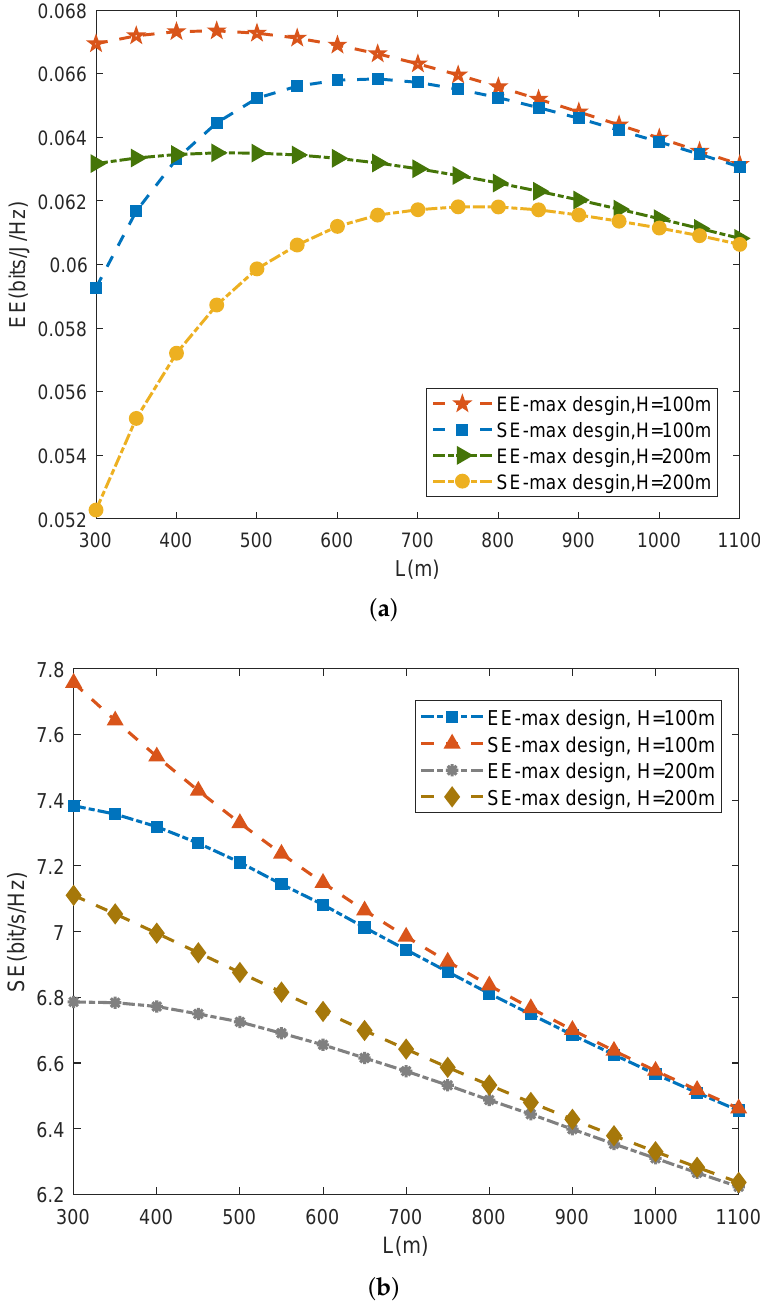
Figure 7. Comparison for different designs. ( a ) EE comparison. ( b ) SE